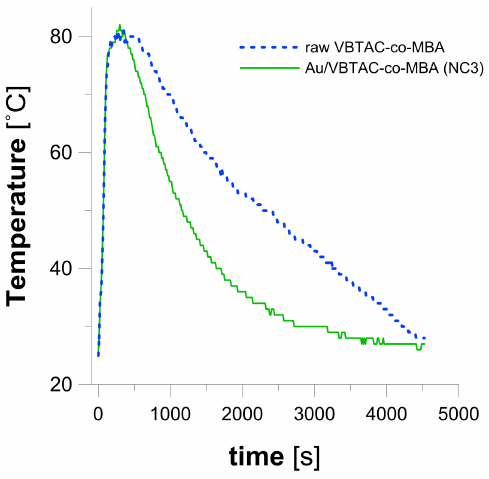
Figure 9. Heating/cooling curves registered for the raw VBTAC- co -MBA and Au/VBTAC- co -MBA